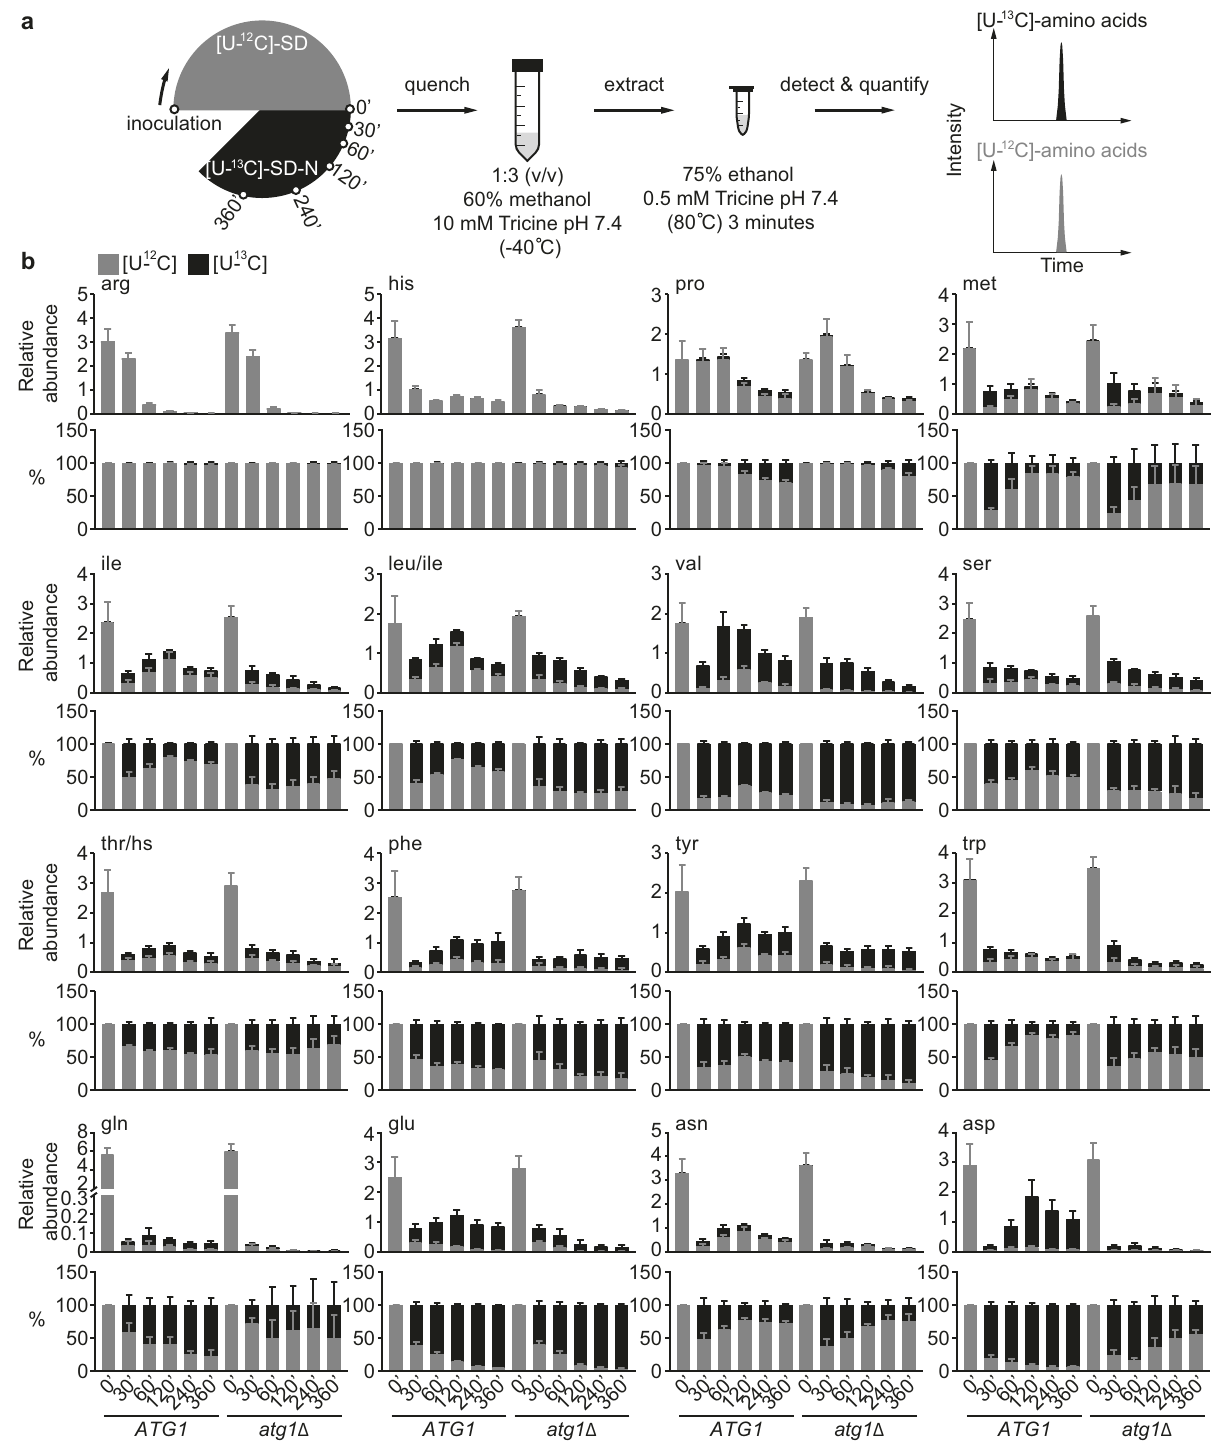
Fig. 2 Autophagy promotes the synthesis of speci fi c amino acids under nitrogen starvation. a Schematic of the experimental design. WT ( ATG1 ) and atg1 Δ cells were grown in SD and starved in [U- 13 C]-SD-N for varying times. Metabolites were extracted and analyzed by LC-MS/MS. b Changes of [U- 12 C]- and [U- 13 C]-amino acids in nitrogen-starved WT and atg1 Δ cells. Three independent replicates for leu/ile, fi ve for his, nine for asp, and six for the remaining amino acids. WT and atg1 Δ cells were always processed and analyzed together and therefore their relative abundances are directly comparable. hs: